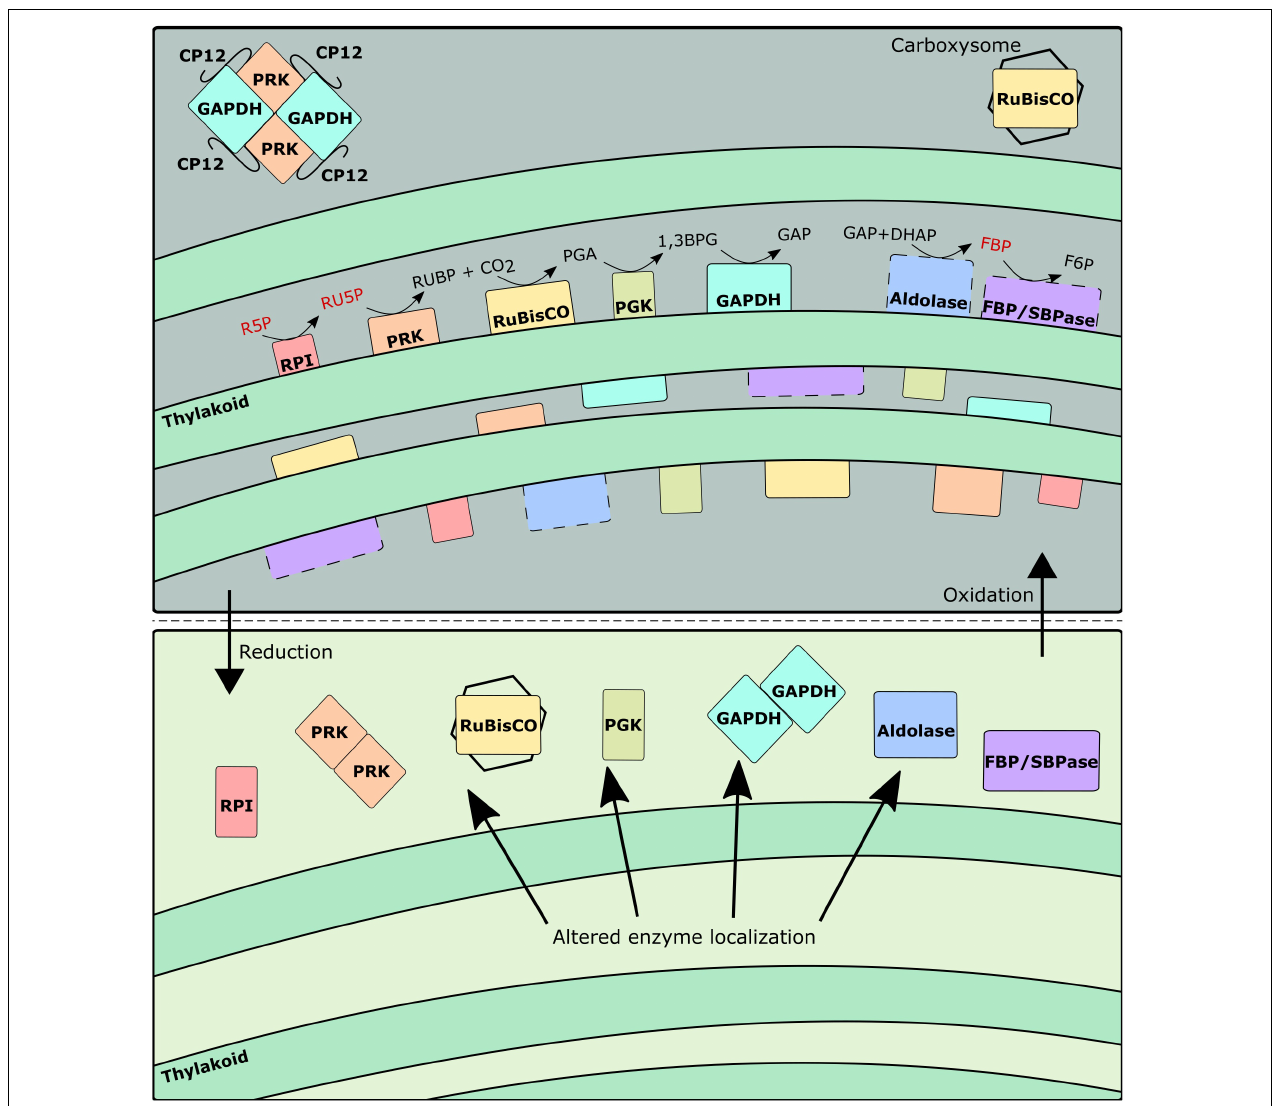
FIGURE 5 | Schematic representing changes to enzyme localization and grouping as a function of redox environment. Dashed lines indicate enzymes not yet confirmed to be thylakoid-bound in Synechocystis . Metabolites in red indicate particularly large inactive pool fractions during oxidative